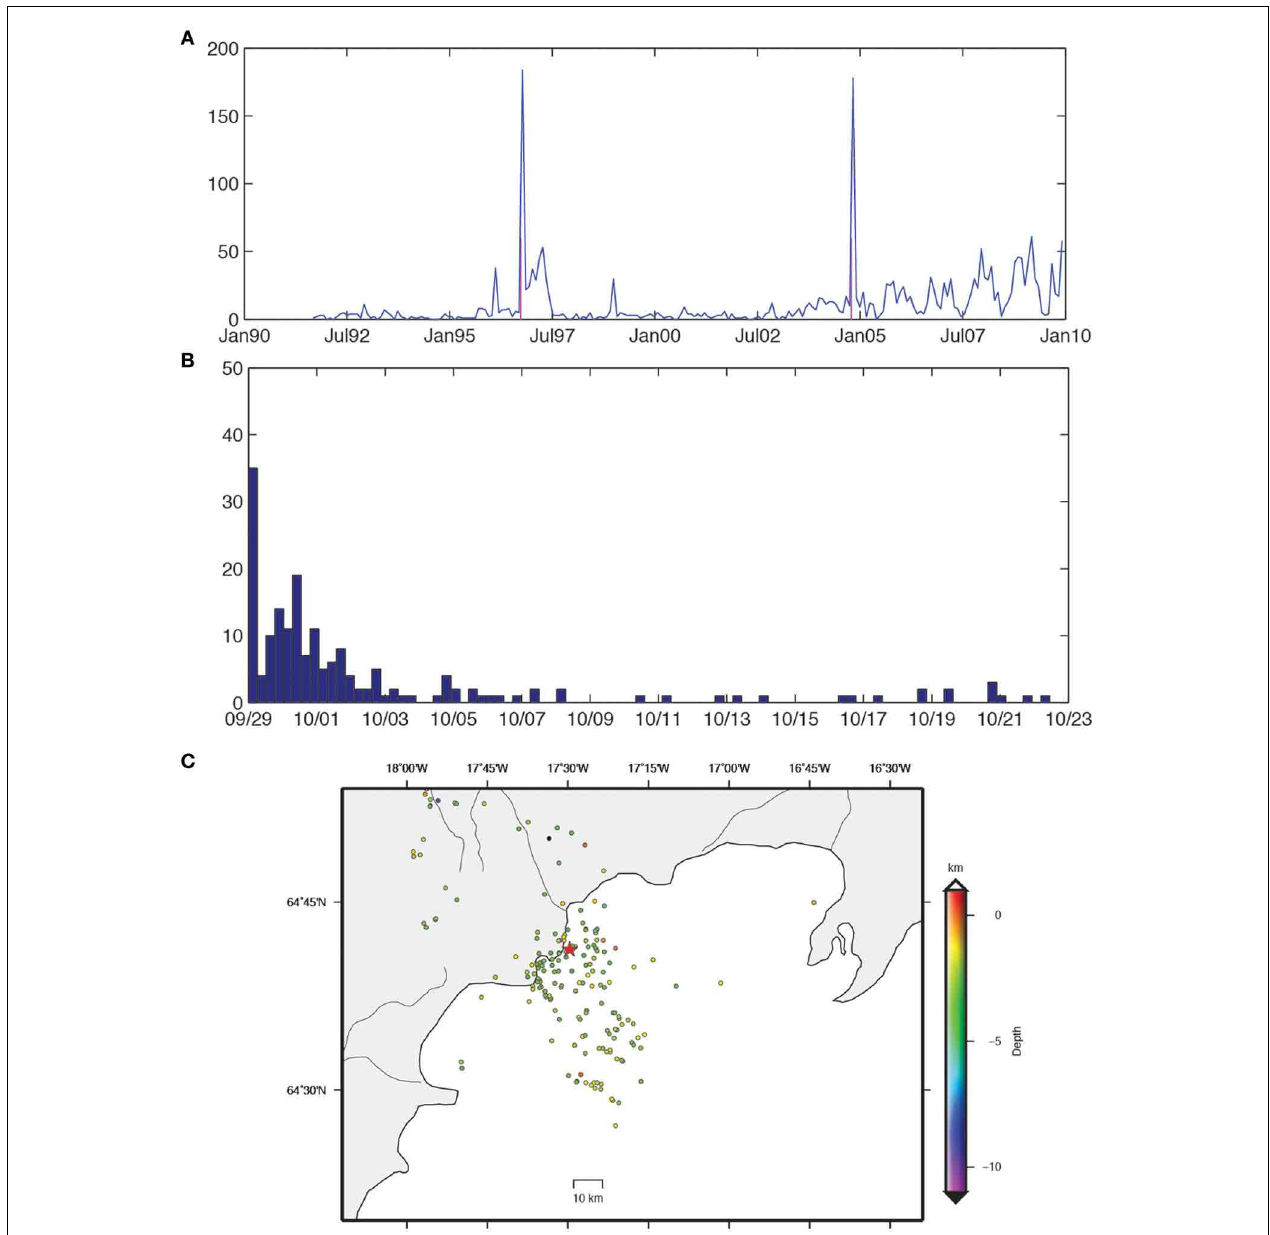
FIGURE 8 | Distribution in time of the seismic events used in this study (see section The Earthquake Catalog Used for Inversion). (A) histogram showing the 20 years span of the database and the two major cluster denoted by the light purple bars based on a time window of 100 earthquakes